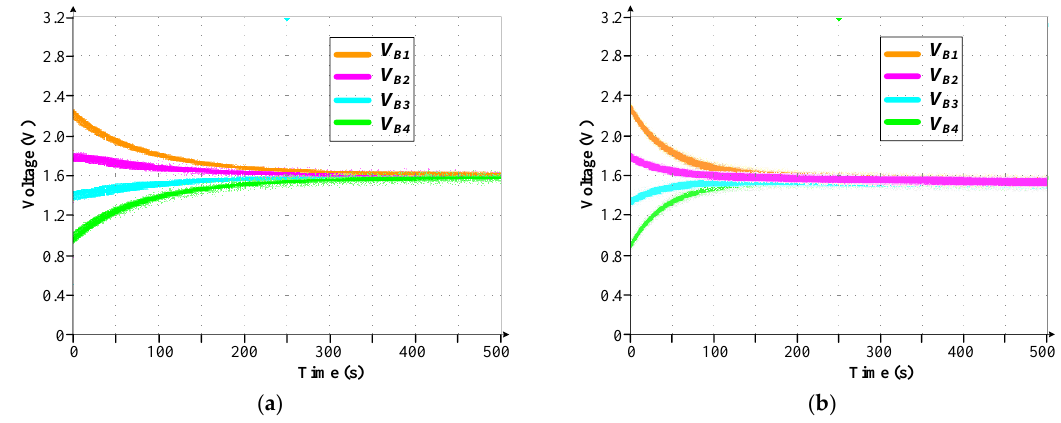
Figure 15. Experimental voltage waveforms of equalization test for four-series electric double-layer capacitors (EDLCs): ( a ) with the conventional equalizer; and ( b ) with the proposed equalizer.